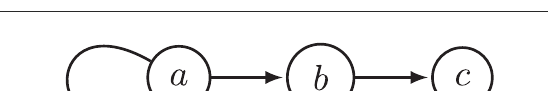
FIGURE4 Argumentation framework F 4 . It shows that complete, grounded, preferred, and semi-stable semantics violate SCOOC since E = {} is an extension, but E is not strongly complete outside odd cycles: b and c are not in an odd cycle, { c } − = { b } , but E does not contain c .